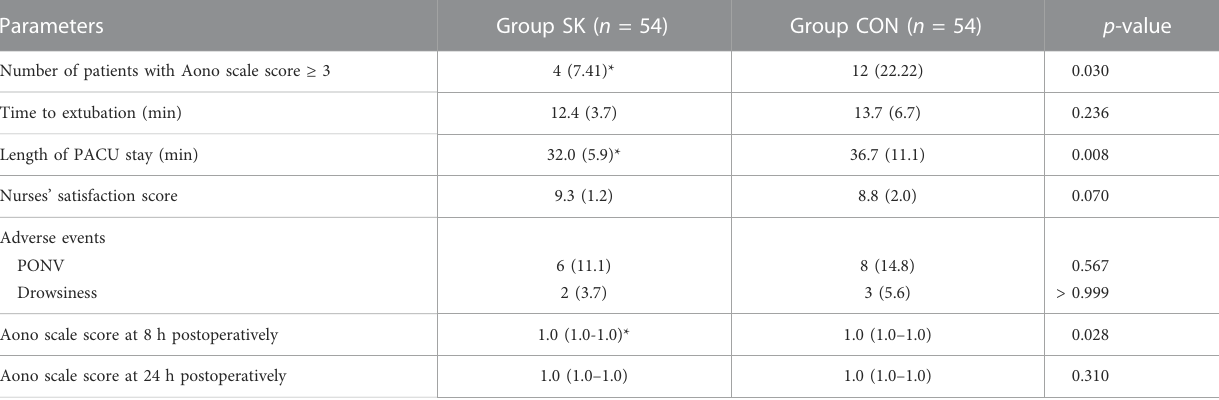
TABLE 4 Postoperative conditions in two groups.